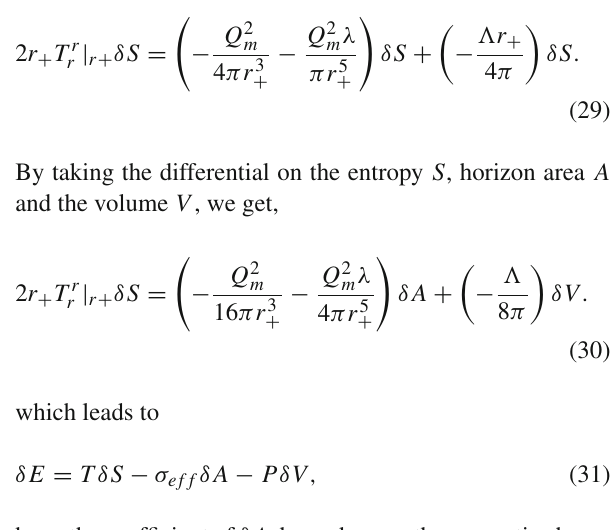
The Gibbs free energy is